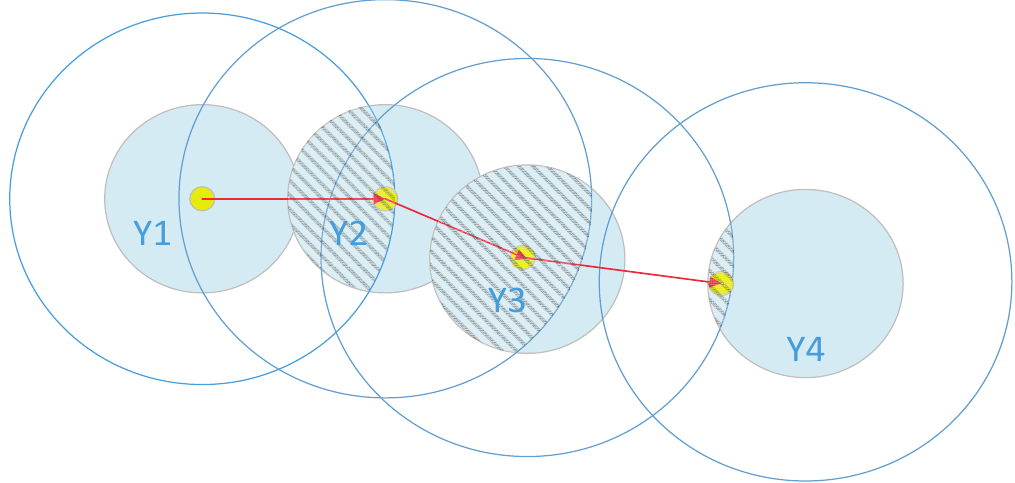
Figure 6. Flow diagram of the location algorithm.